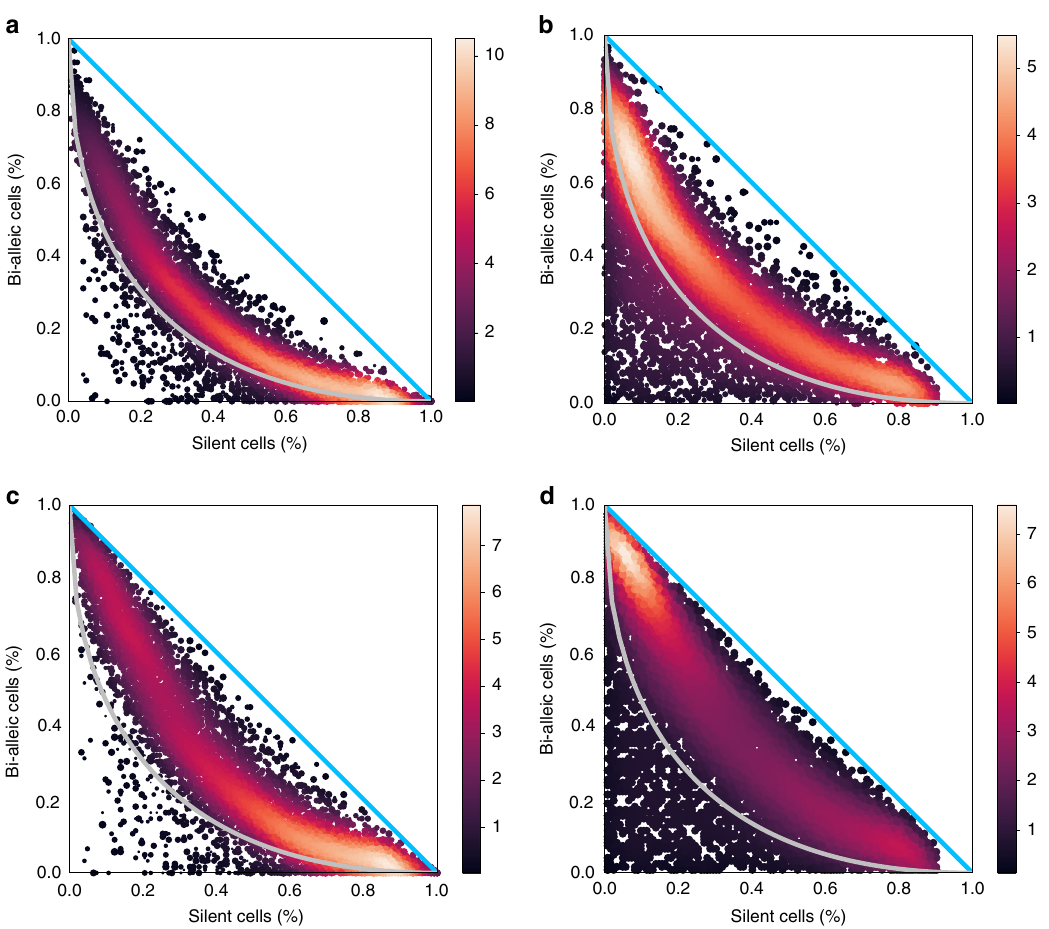
Fig. 5 Independence of allelic bursting (continued). Four panels illustrate the proportions of bi-allelic and silent cells as estimated from a unique reads, b weighted allocation, c unique reads with partial pooling, and d weighted allocation with partial pooling. Points representing individual genes are shown